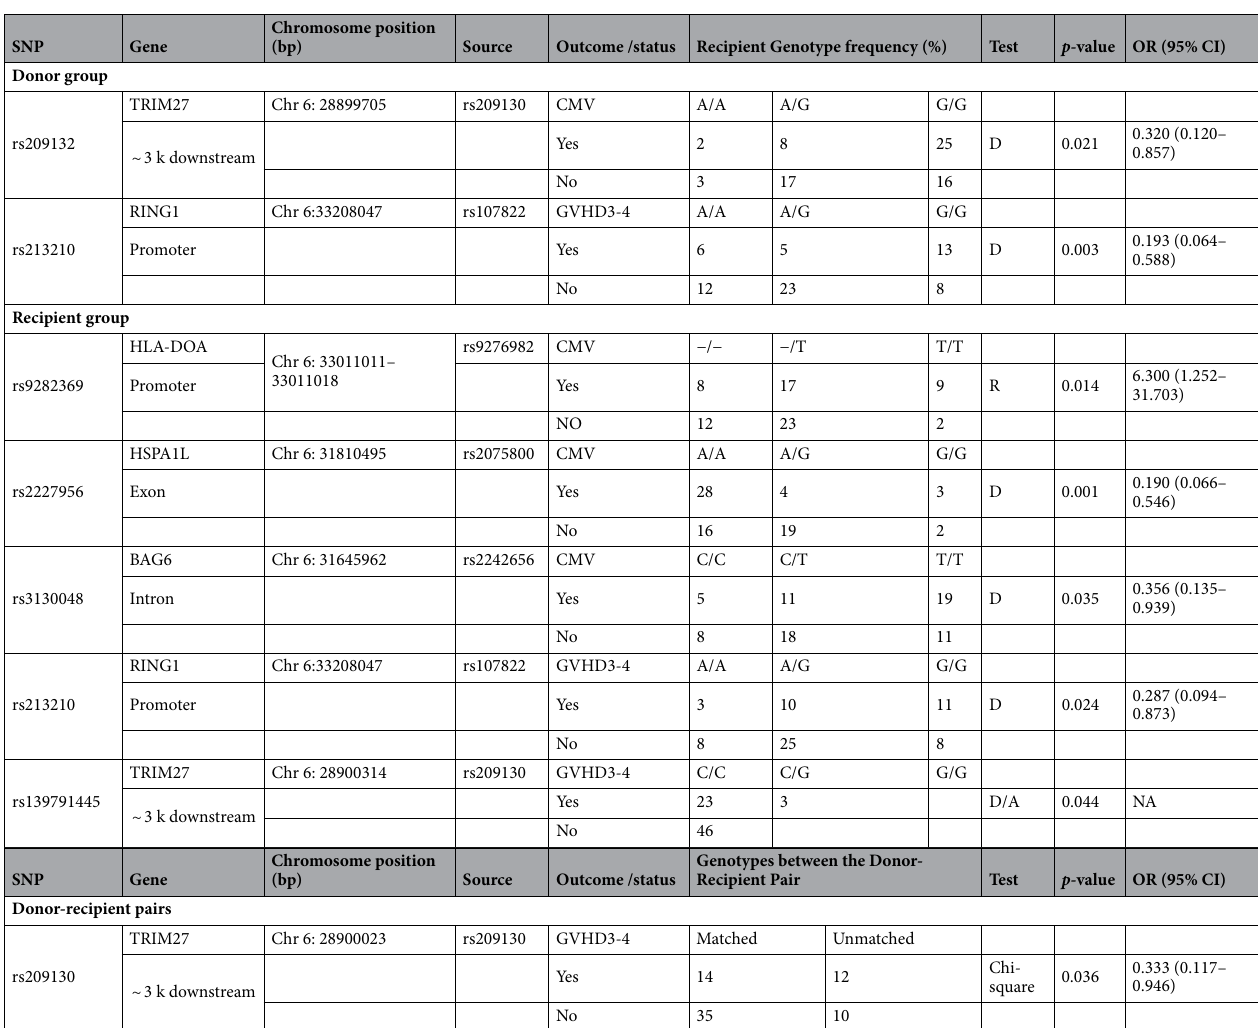
Table 2. The SNPs significant association with three adverse reactions in ALL group. D: dominant model (AA vs. Aa + aa); R: recessive model (AA + Aa vs. aa); A: additive model (AA vs. Aa vs. aa), in which ‘A’ was defined as a higher frequency allele and the lower was ‘a’. Fisher’s exact test was used when more than 20% of cells had an expected count of less than 5 for the Chi-square test. The unmatched was used as a standard for odds ratio here. In other words, the chance for getting CMV infection, severe GVHD and survival in the matched genotype in donor-recipient pairs compared to those